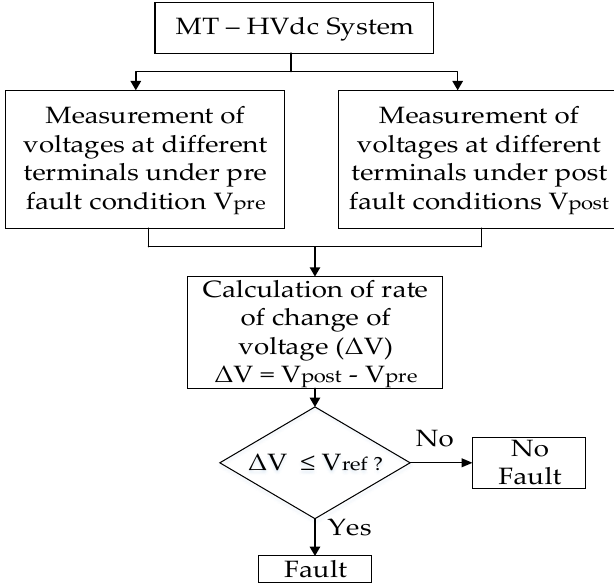
Figure 22. NTW method based on rate of change of voltage.